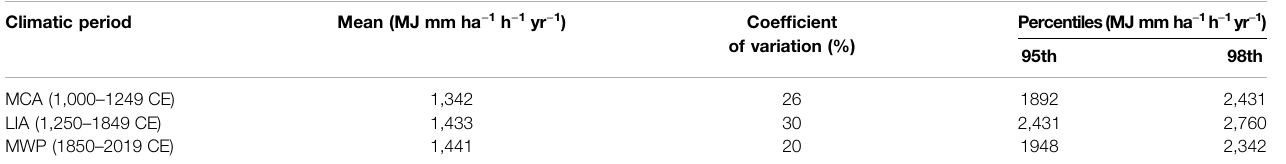
TABLE 1 | Descriptive statistics for three climatic periods of the modeled time series of rainfall erosivity. MCA: Medieval Climate Anomaly; LIA: Little Ice Age; MWP: Modern Warming Period. Climatic period